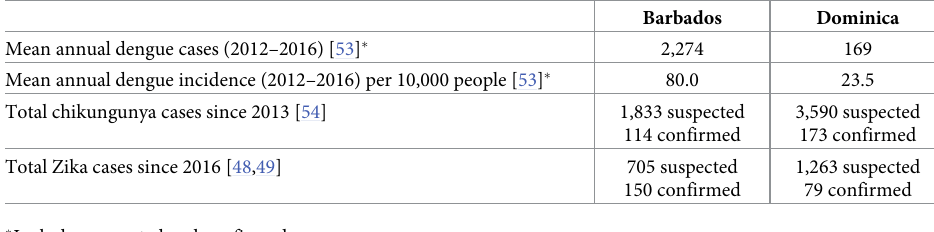
Table 1. Arboviral disease cases in Barbados and